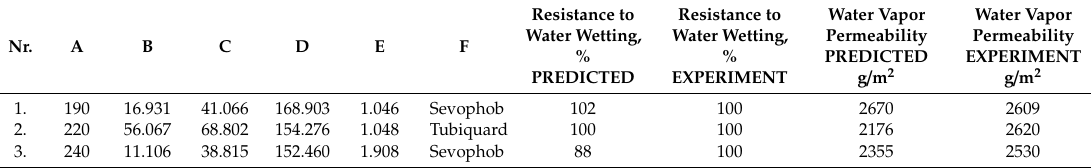
Table 3. Verification experiments at optimum conditions of process parameters (A—fabric